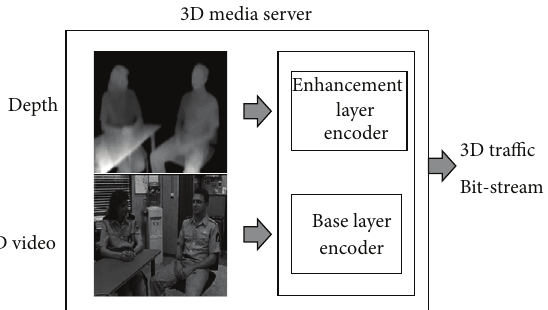
used to encode both the 2D video and the depth map sequence. After delivery, the base and enhancement layers are decoded as the 2D video and the depth image sequence on the receiver side. Before displaying 3D video on the display,